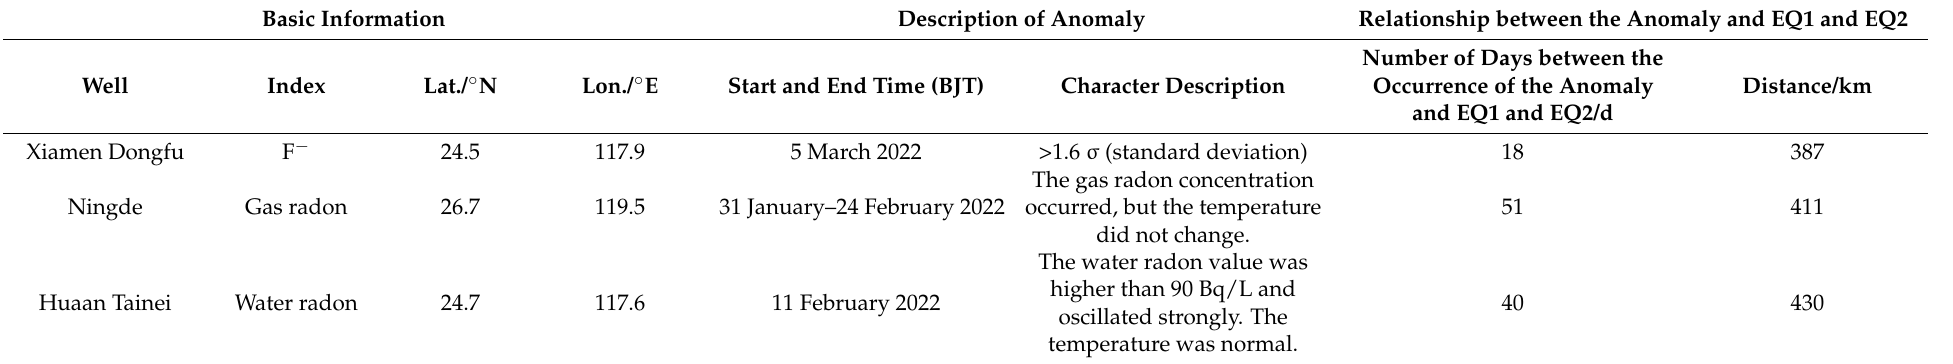
Table 3. Details of underground fluid precursor anomalies before EQ1 and EQ2 (23 December 2021–22 March